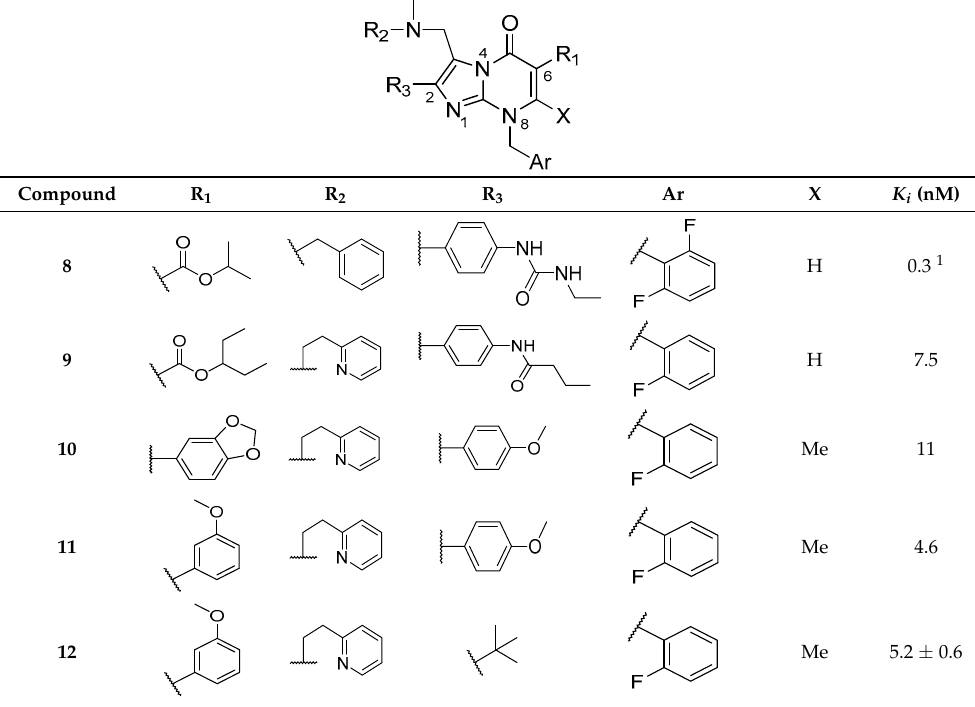
Table 4. Imidazolo[1,2- a ]pyrimidin-5-one and their binding affinity at human GnRH-R.